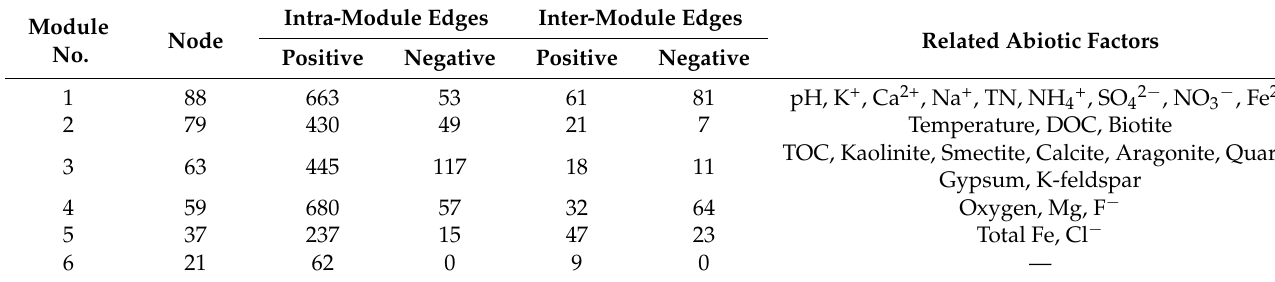
Table 2. Information for individual modules.